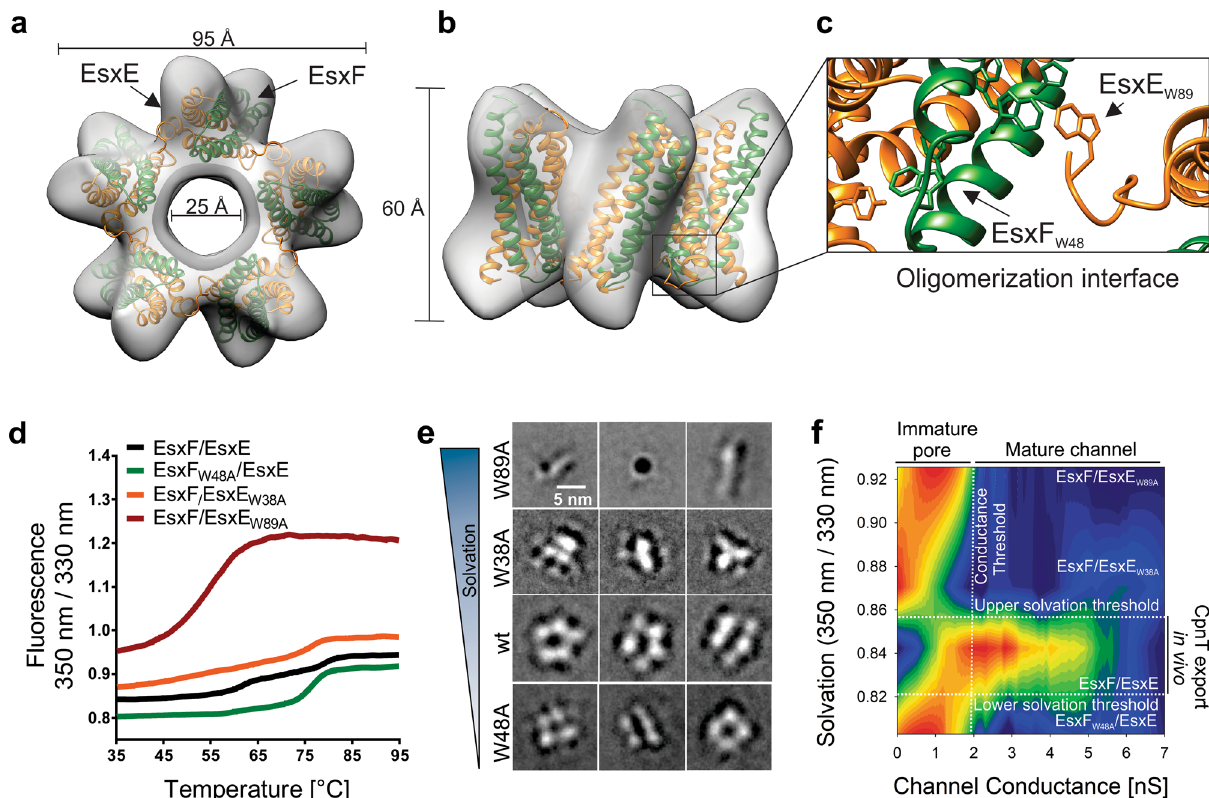
Fig. 6 Conformational dynamics of EsxE-EsxF pore assembly revealed by electron microscopy. a Pentameric 3D reconstruction from negatively stained EsxEF particles. The EsxEF homology model was fi t to the density using rigid-body fi tting in Chimera. Shown is the bottom view. The electron density map for EsxEF is deposited in the electron microscopy data bank (EMDB code: EMD-22727). b Side view of the 3D reconstruction shown in a . c Putative oligomeric interface formed by the WXG motif of EsxF (green) and the CTD of EsxE (orange). d Differential scanning fl uorimetry of the indicating proteins, indicating the thermostability of the proteins and the water accessibility of the tryptophan residues. e Reference-free 2D class averages of the indicated EsxE-EsxF protein particles obtained by negative stain electron microscopy ranked by solvation as determined in e . The complete class averages are shown in Fig. S7. Data are from a single EM session. Representative images of at least two experiments are shown. f Contour map of the solvation value (350 nm/ 330 nm) obtained from d versus the total number of channel insertions (Fig. S6) for each examined EsxE-EsxF variant. The thresholds were determined based on the event frequency. The WXG variants of EsxE-EsxF form immature pores whereas “ mature channel ” were formed by wt EsxE-EsxF. The total number of insertions for each protein at each conductance value was smoothed and normalized in Graphpad. Smoothed data were then plotted against the respective solvation values using SigmaPlot. Source data are provided in the Source data fi